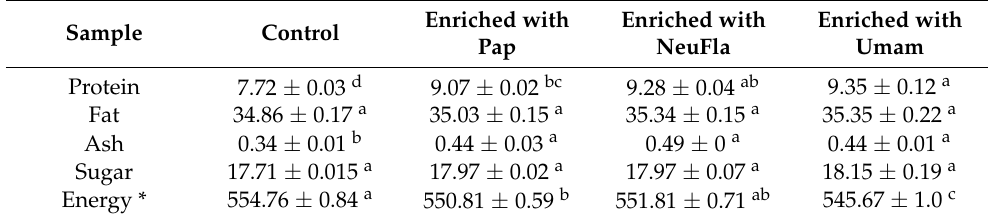
Table 4. Chemical analysis of the control cookies and cookies enriched with three selected hy- drolysates (% dry matter).